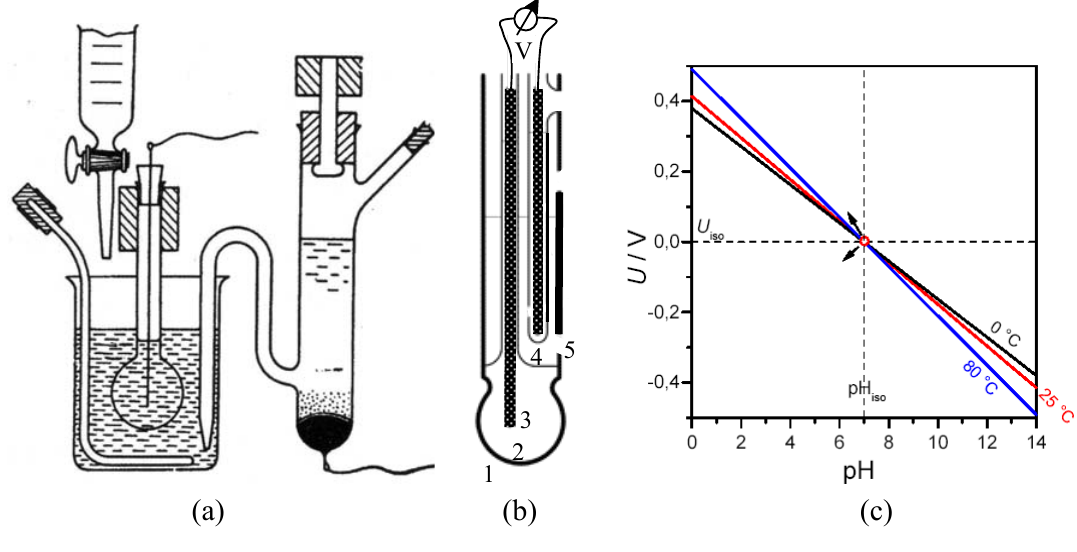
Figure 1. (a) Experimental setup by Haber and Klemensiewicz. (b) Single-rod measuring cell with double junction: 1 = solution, 2 = inner electrolyte (KCl, 3 mol/L, pH 7), 3 = reference electrode, 4 = external Ag|AgCl|KCl reference electrode, 5 = junction. (c) Ideal chain voltage versus